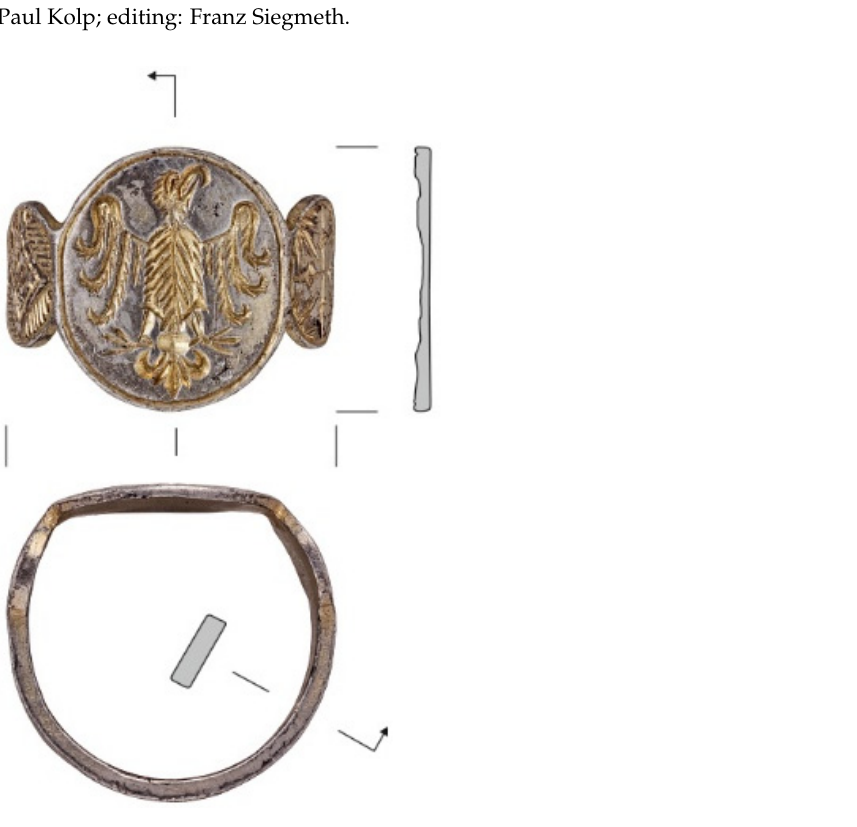
Figure 3. Treasure from Wiener Neustadt. Finger ring with “eagle” motif, 13th/14th century. Photo: Paul Kolp; editing: Franz Siegmeth.